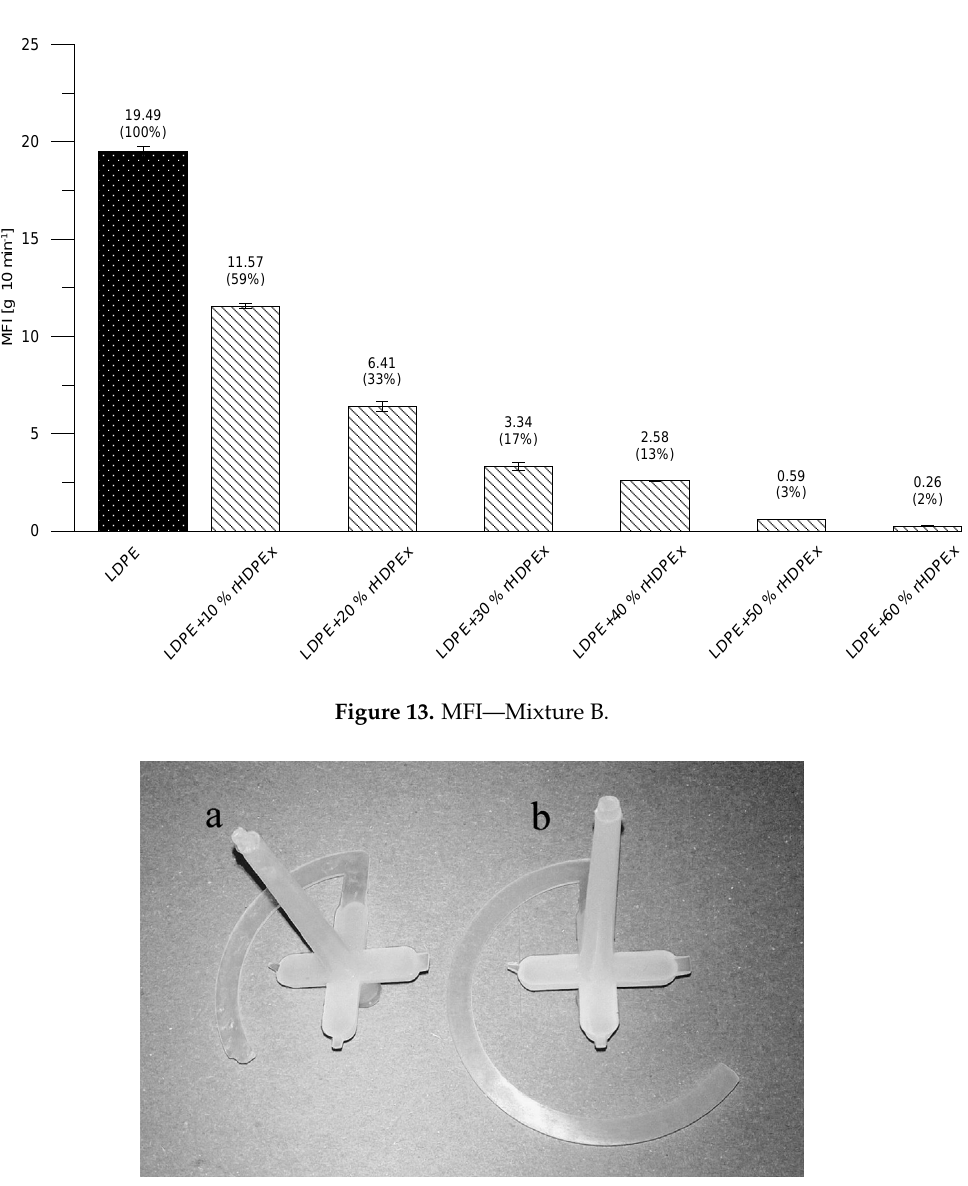
Figure 14. Resulting spirals: ( a ) LDPE + 60% rHDPEx (Mixtures A); and ( b )